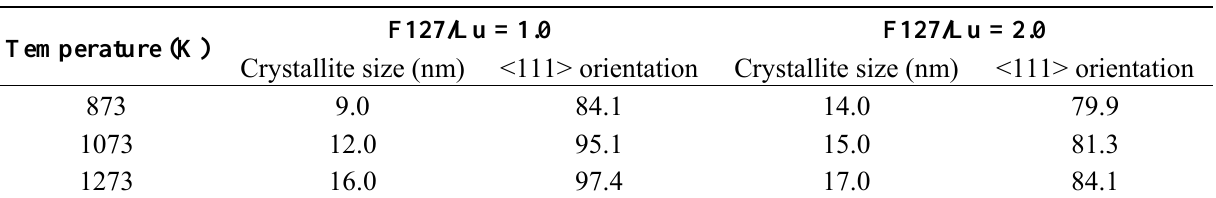
Table 1. Crystallite size and preferential orientation as a function of the heat treatment temperature of Lu O :Eu 3+ F127 modified thin 2 3